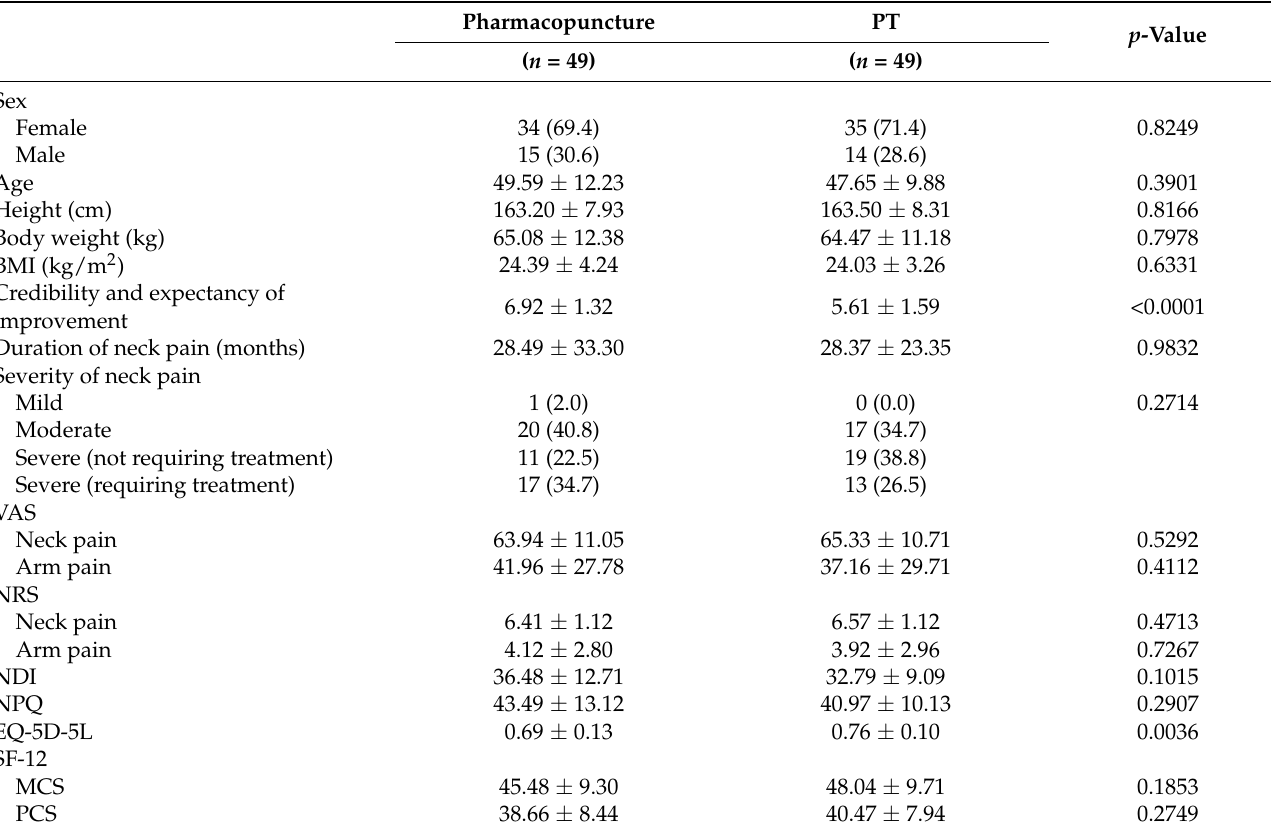
Table 1. Baseline characteristics of the